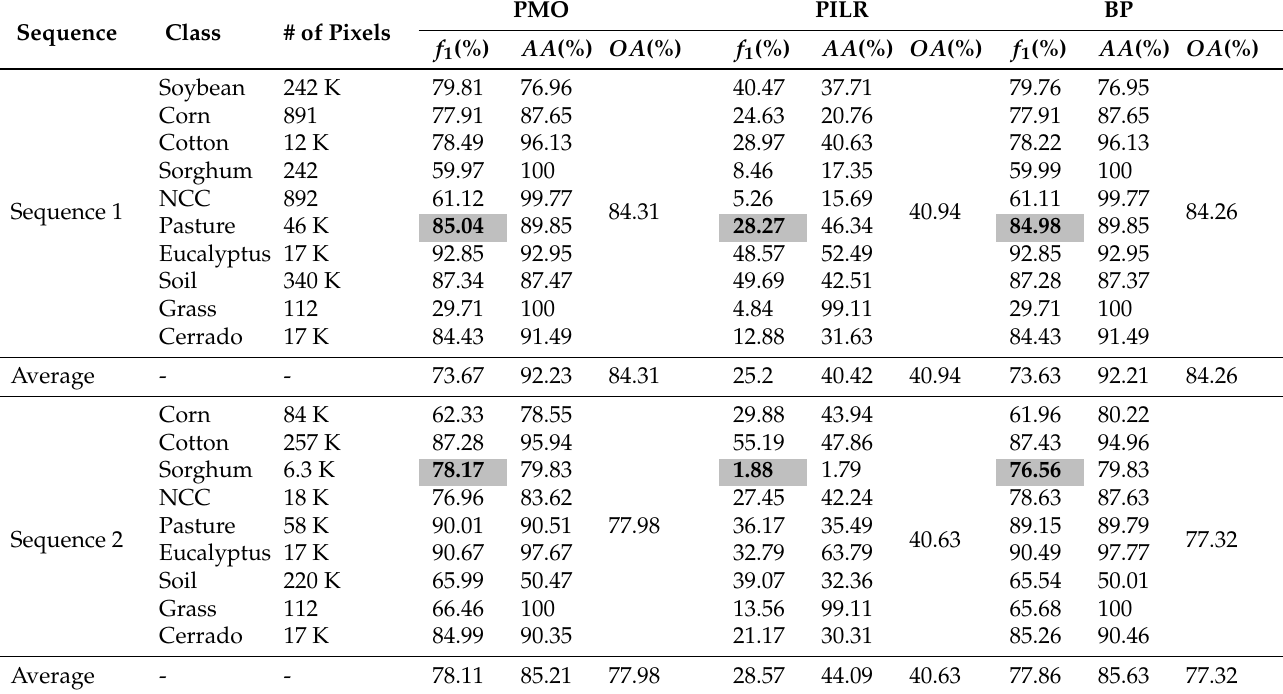
Table 5. The overall performance reached by the proposed methodology with post-processing techniques. The most significant differences between the values of the techniques are highlighted. PMO: post-processing technique based on morphological operations. PILR: post-processing based on iterative label refinement; BP: before post-processing.